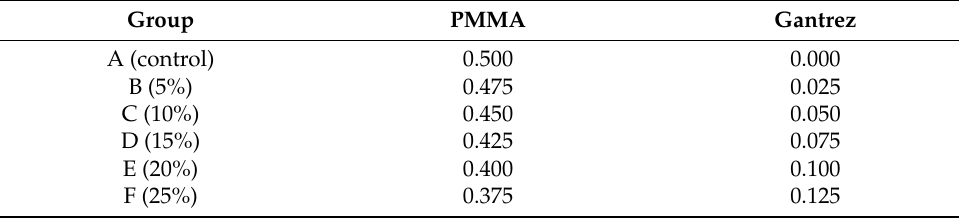
Table 5. Formulation ratios of PMMA and